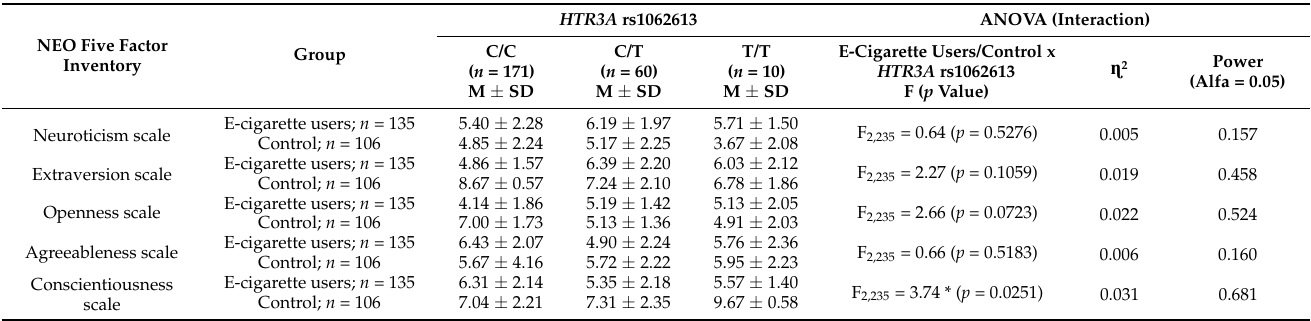
Table 5. The results of 2 × 3 factorial ANOVA for e-cigarette users and controls, NEO Five Factor Inventory and HTR3A rs1062613.